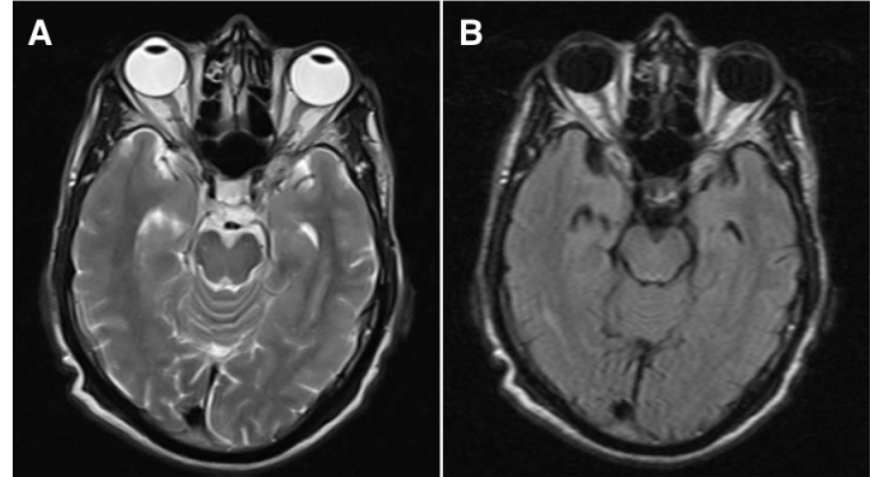
Figure 3: Magnetic resonance imaging of the brain and orbit by axial T2-weighted sequence (A) and fluid-attenuated recovery (FLAIR) sequence images (B) do not show any lesions in the choroid, optic nerve or orbit on both sides . retinal hemorrhages were striking (arrows, Figure 1).